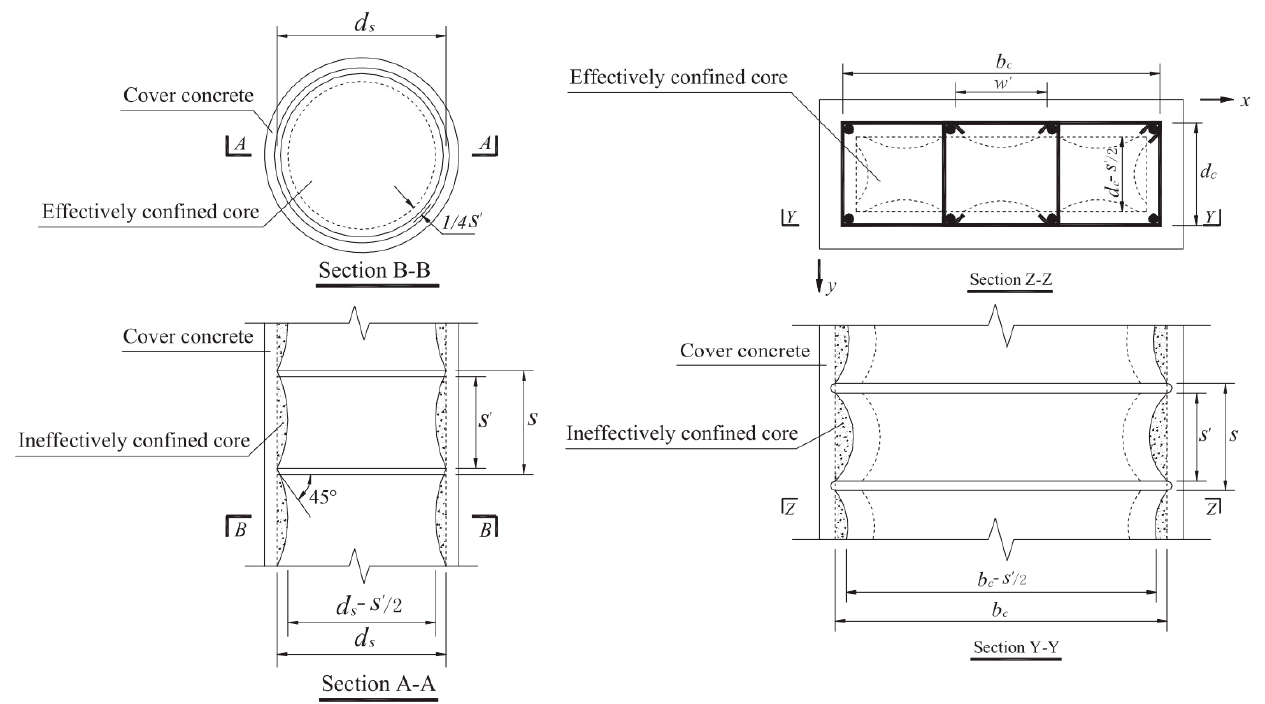
Figure 9. Effectively restrained area of transverse reinforcement.